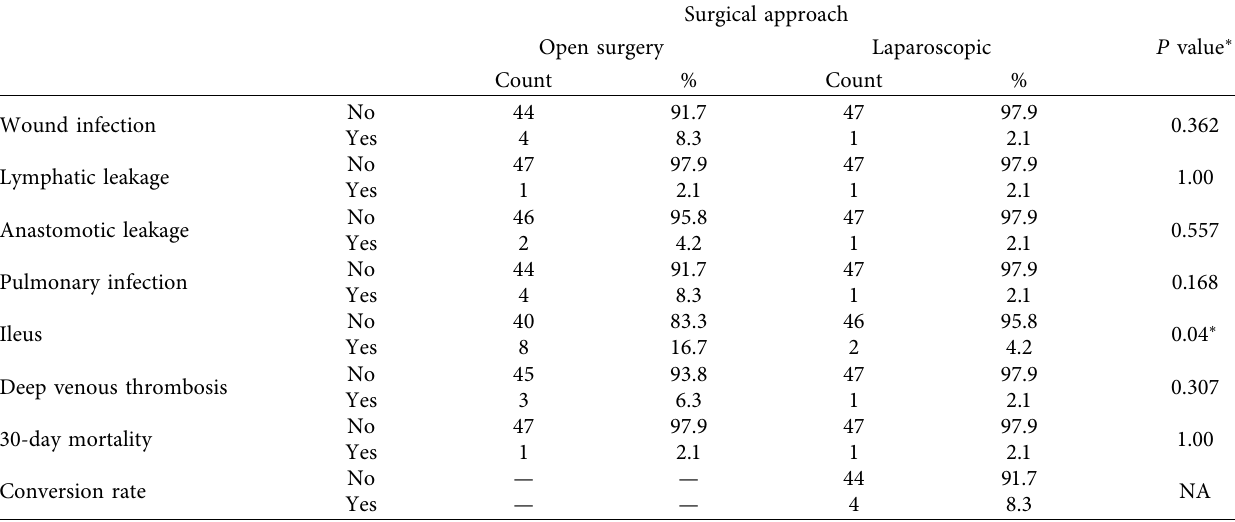
Table 4: Postoperative complications.